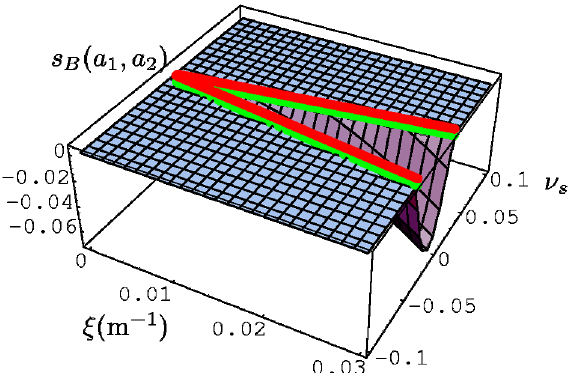
(36).FIG. 8. (Color) Unstable region caused by two crab cavities, (cid:20) apart in betatron phase for (cid:28) (cid:2) 8 : 025 . Light green: border of stability; dark red: border of stability from the approximate Eq.